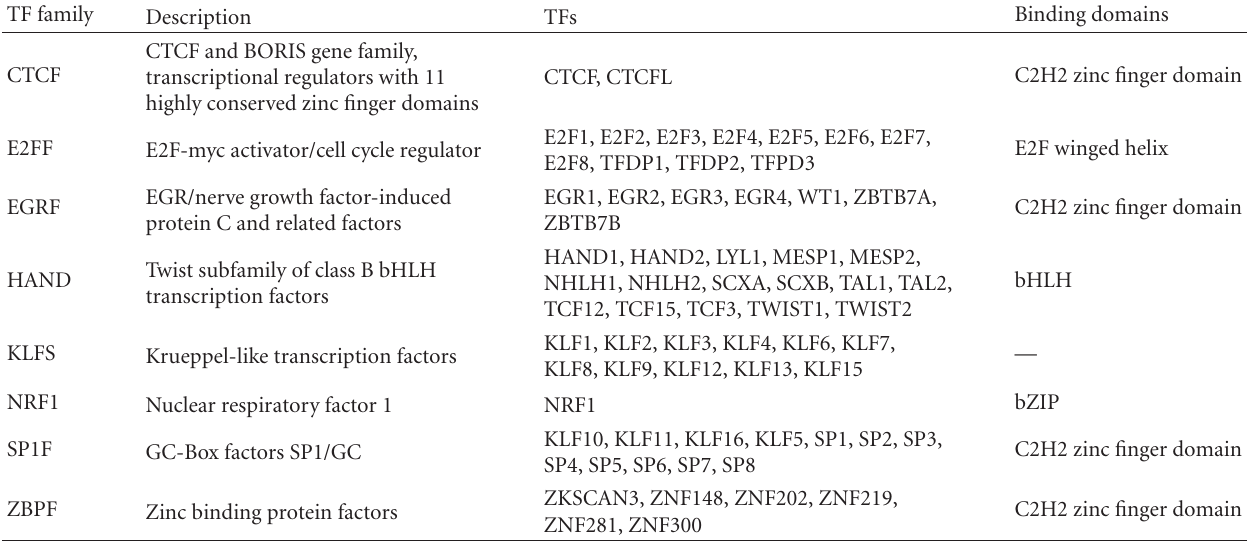
Table 2: Composition of the TF families of the modules. Each TF family consists of several transcription factors (TFs). Additional information about description and binding domains of the families is given in the second and fourth column,